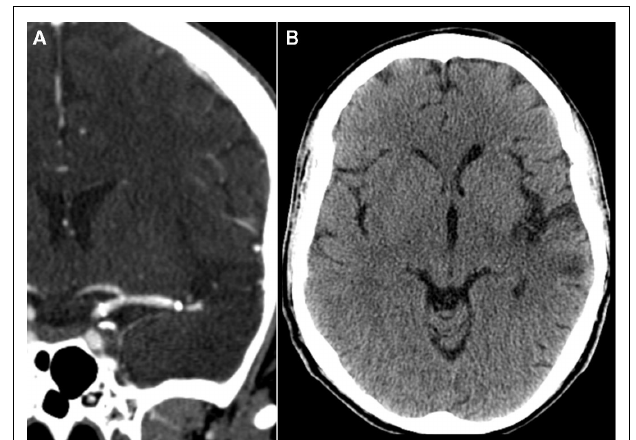
FIGURE 1 | Computed tomography perfusion (CTP) of a 53-year-old man who presented with a National Institute of Health Stroke Scale of 20 approximately 2h after symptom onset. The perfusion map demonstrates a mismatch with increased mean transient time (A) and normal blood volume (B) in the left middle cerebral artery (MCA) territory.